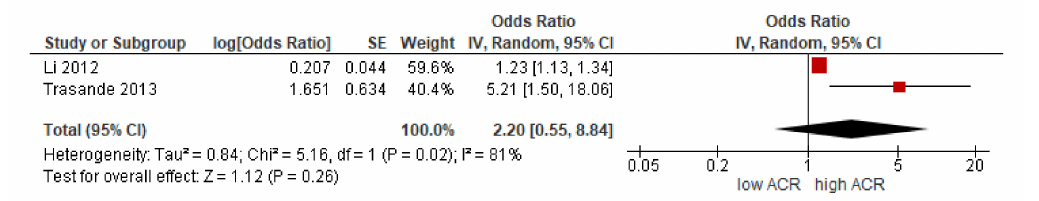
Figure 6. Analysis of the inverse of variance of the two publications that study BPA in urine and low-grade albuminuria [21,23]. ACR: urine albumin-to-creatinine ratio.